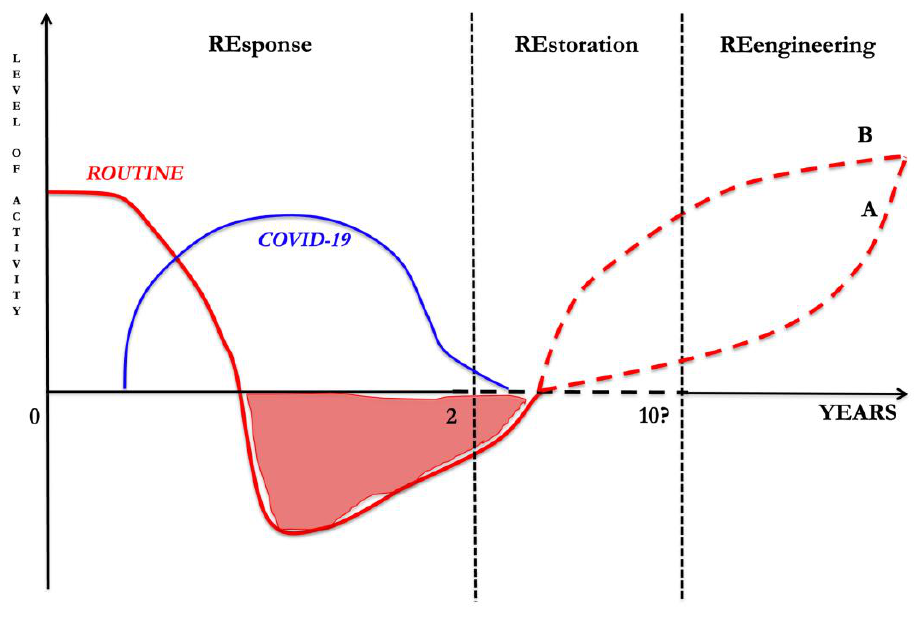
Figure 1. The RE-RE-RE approach to the pandemic.